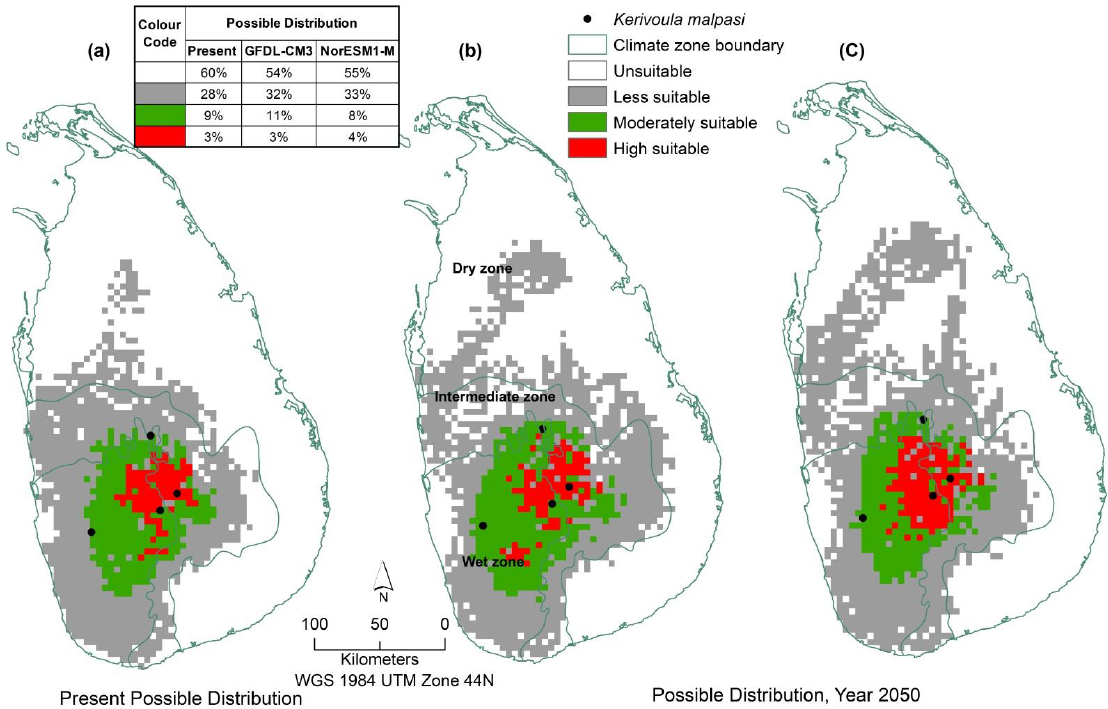
Figure 4. MaxEnt-based habitat suitability maps for current ( a ) and future (2050) distribution ranges based on GFDL-CM3 ( b ) and NorESM1-M climate change forecasts ( c ) for K. malpasi in Sri Lanka. Table tallies proportional changes in distribution acreage between current and future scenarios.